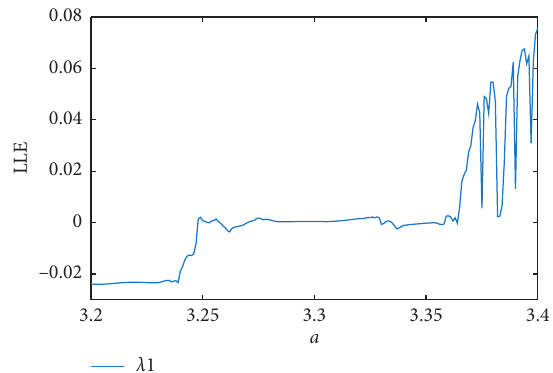
Figure 6: Largest Lyapunov exponent of 3D jerk system (1) for b � 1 and c � 4.